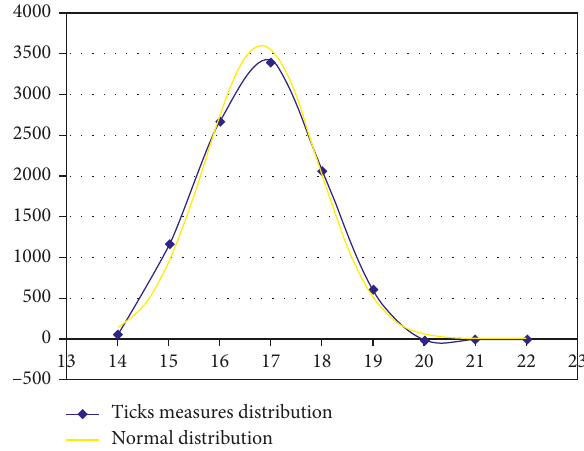
Figure 2: Graphical representation of ticks measurements distri- bution for 80bytes